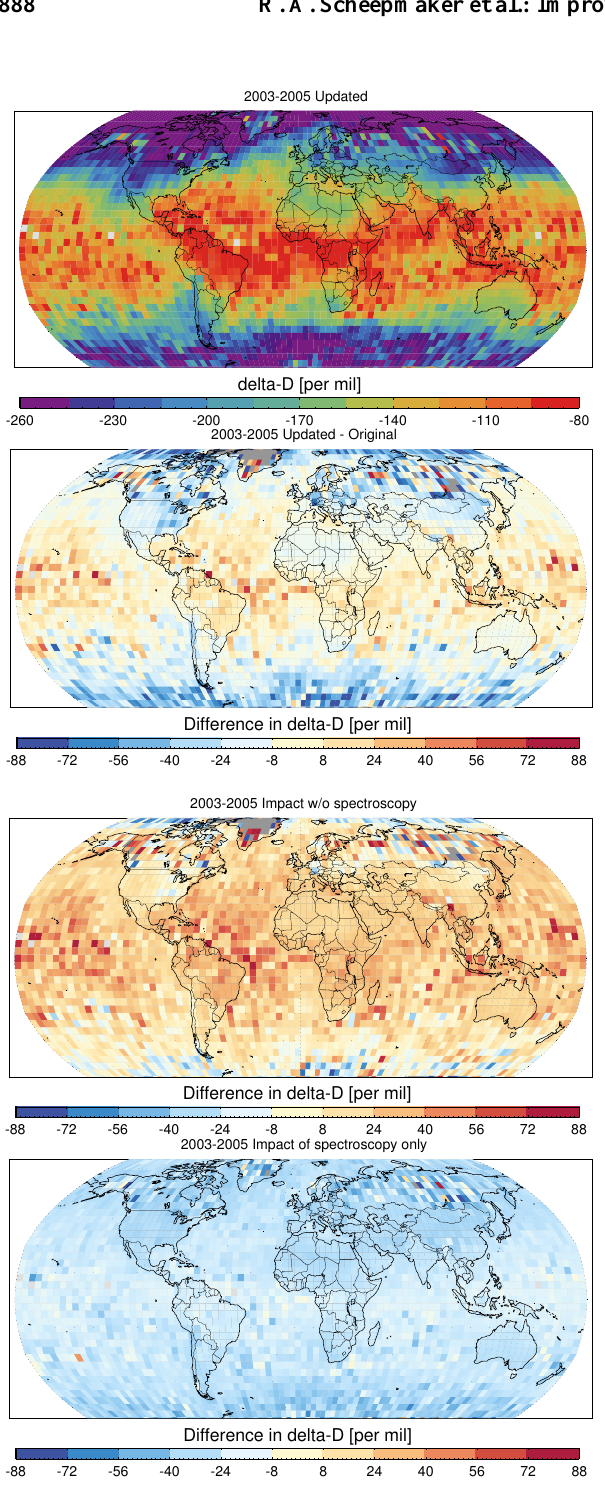
Fig. 9. Top: updated 2003–2005 global average world map of δ D. Second: difference between the updated world map and the orignal world map from Frankenberg et al. (2009). Third: impact on the world map solely caused by updates in the instrument calibration (the original spectroscopy was used). Bottom: impact on the world map solely caused by the updated